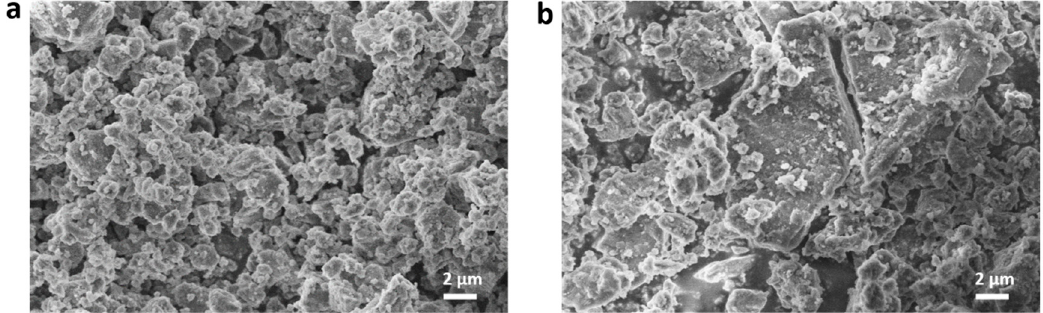
Figure 2. SEM images of the samples ( a ) NBOM_36 and ( b ) LBOM_36.